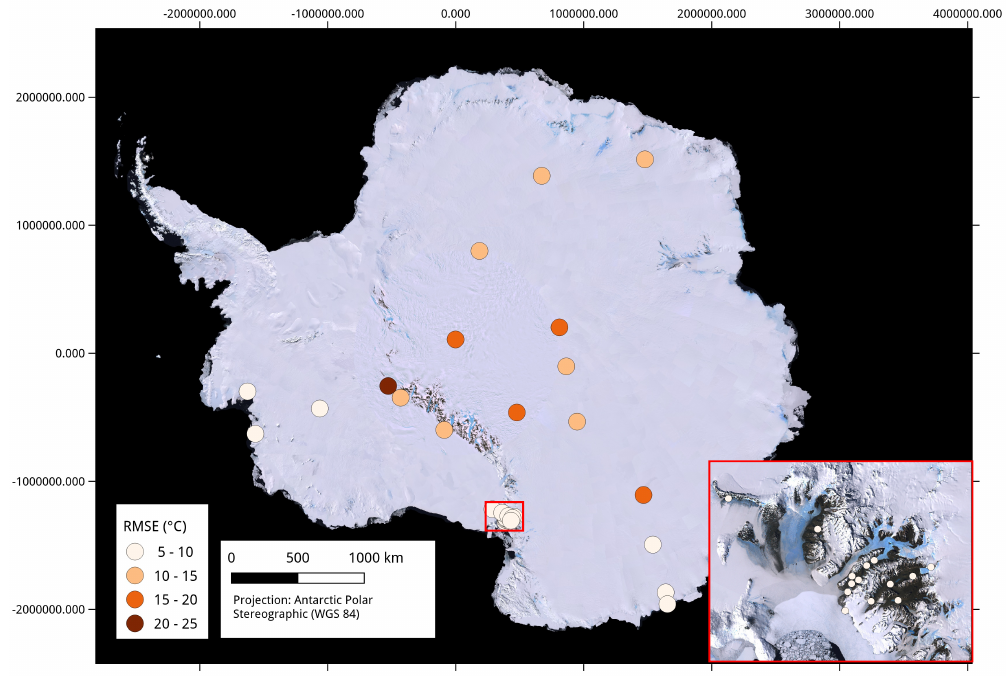
Figure 8. Spatial distribution of RMSE of predicted T air for the 32 weather station. The McMurdo Dry Valleys are shown in detail. The weather stations are overlayed on a Landsat composite image